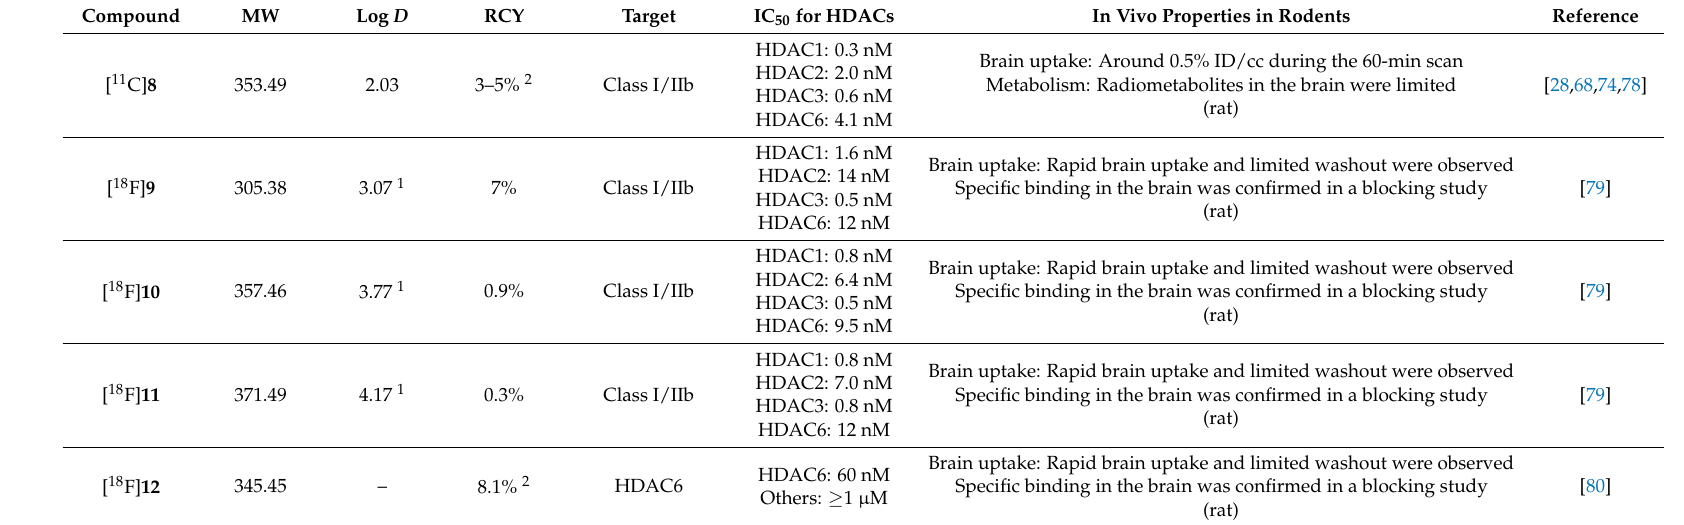
Table 2. Physiochemical properties of radiolabeled adamantane-conjugated HDAC ligands. Compound In Vivo Properties in Rodents